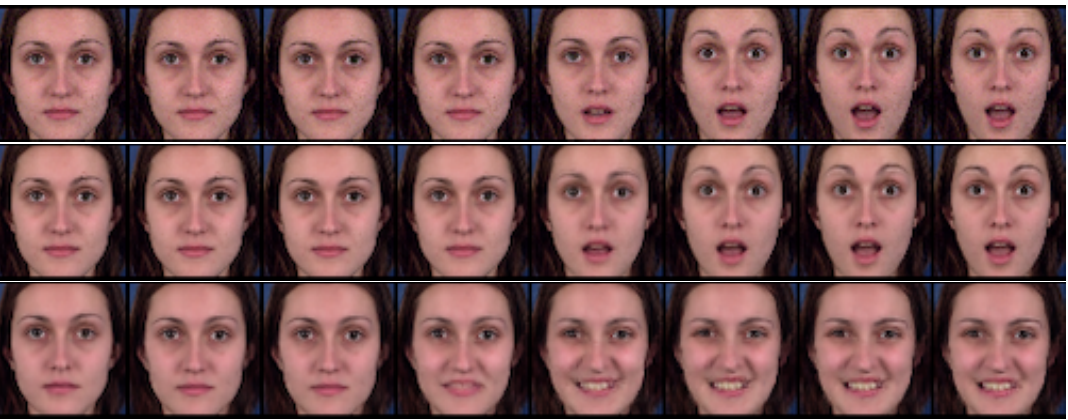
Figure 10. Example of randomly sampled generation on the MUG dataset. We fixed the static variable and randomly sampled the dynamic variables. The top, middle, and bottom rows denote the input video and the results using DSVAE and the proposed method,